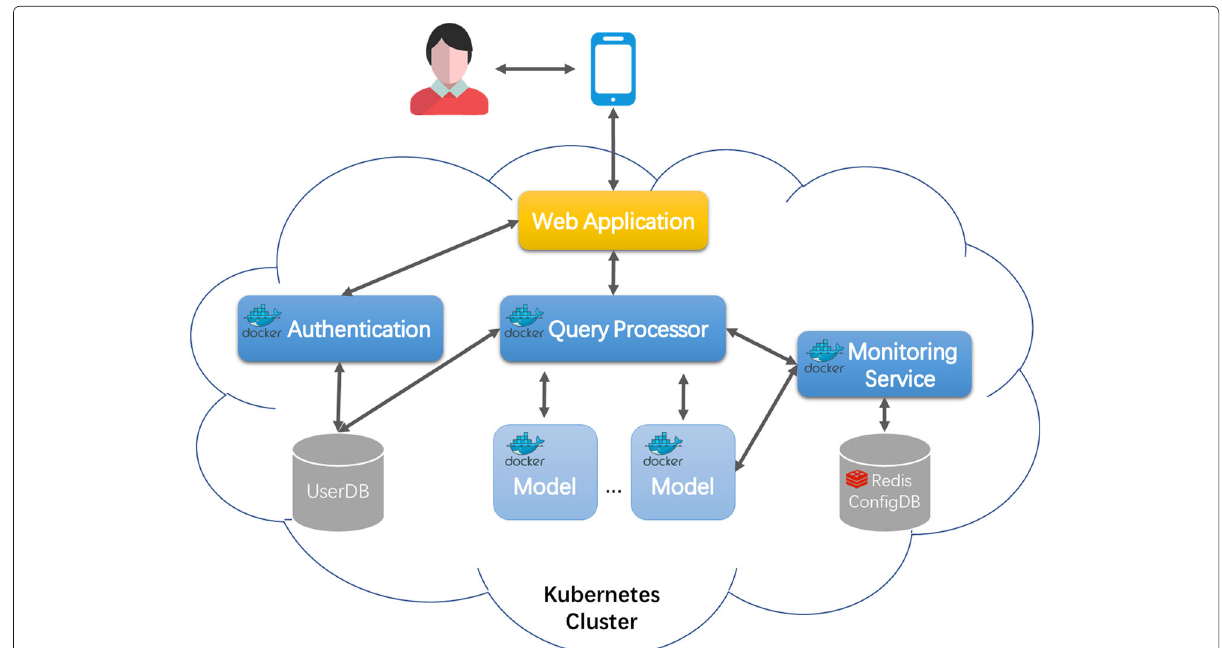
Fig. 1 The cloud computing architecture of proposed